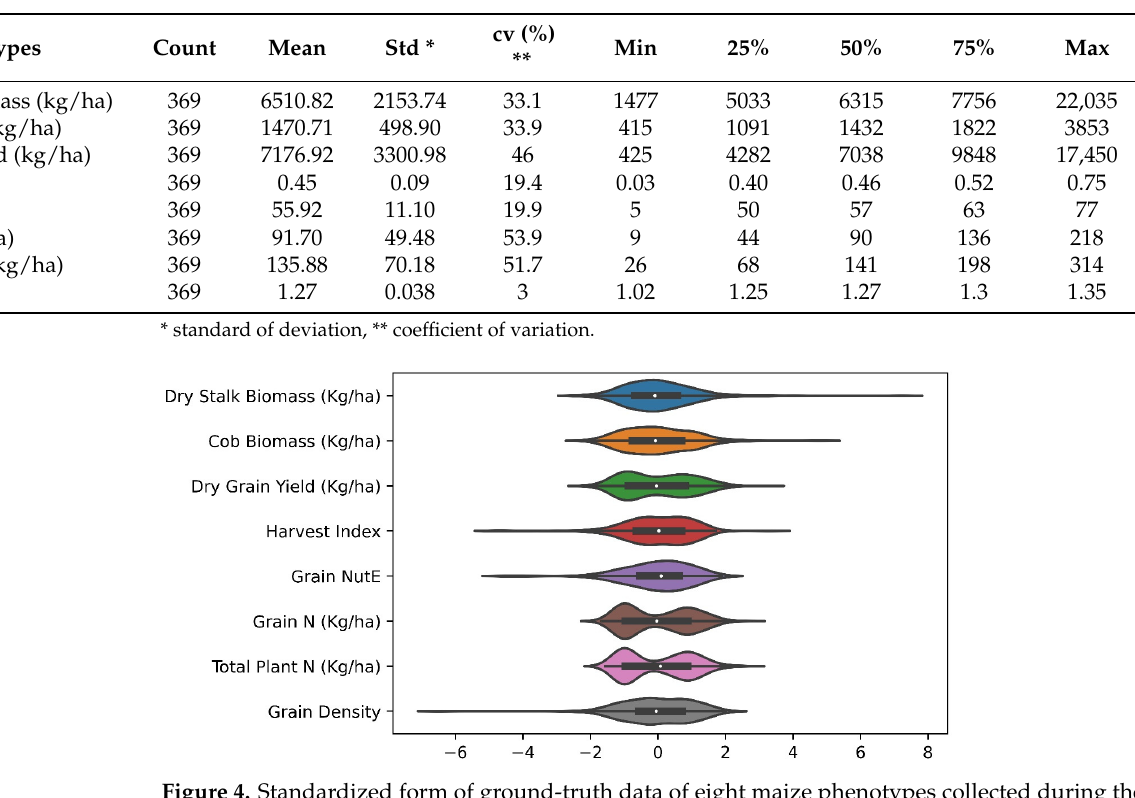
Table 3. A summary of descriptive statistics of each maize phenotype collected at the end of grow- ing season.